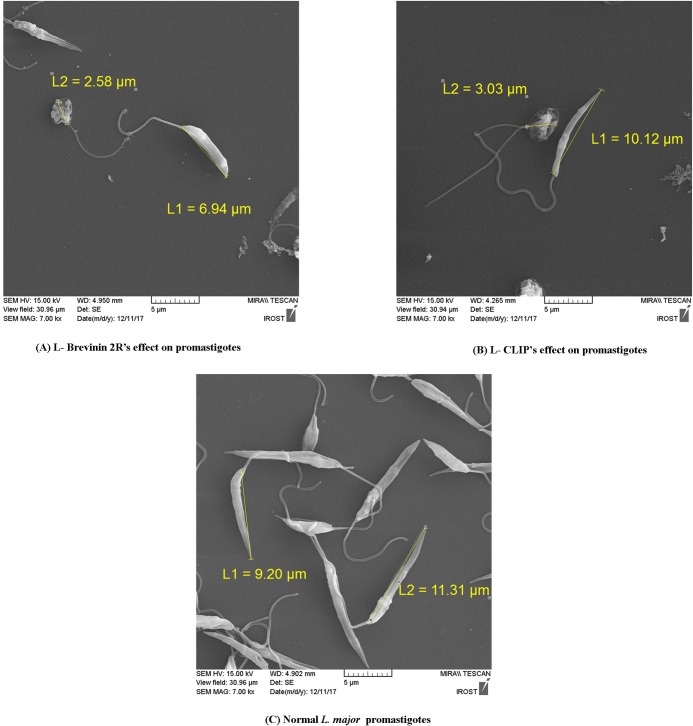
SEM view of promastigotes exposed to the IC50 concentration of L- Brevinin 2R (A), L- CLIP (B) and normal promastigotes (C). Pictures were captured with 7000X magnification.